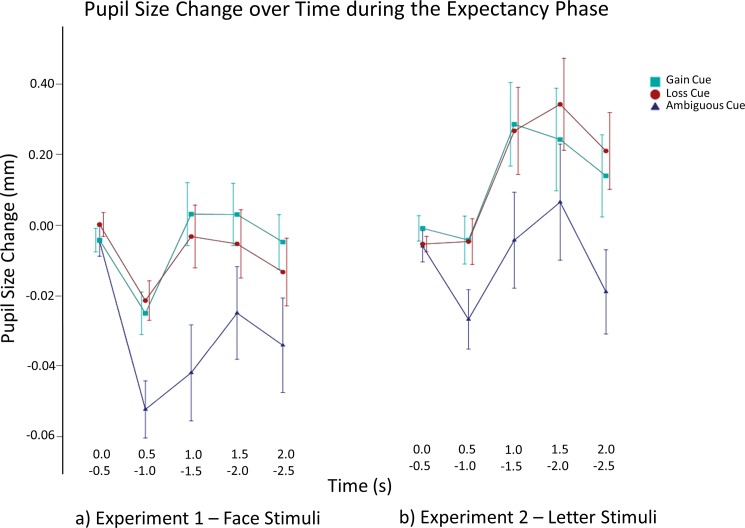
Pupil diameter change during the expectancy phase as a function of time and expectancy cue.Gain cue, loss cue, and ambiguous cue refer to the gain 90%, loss 90%, and gain loss [loss gain] 50% cues, respectively. The error bars depict standard errors.